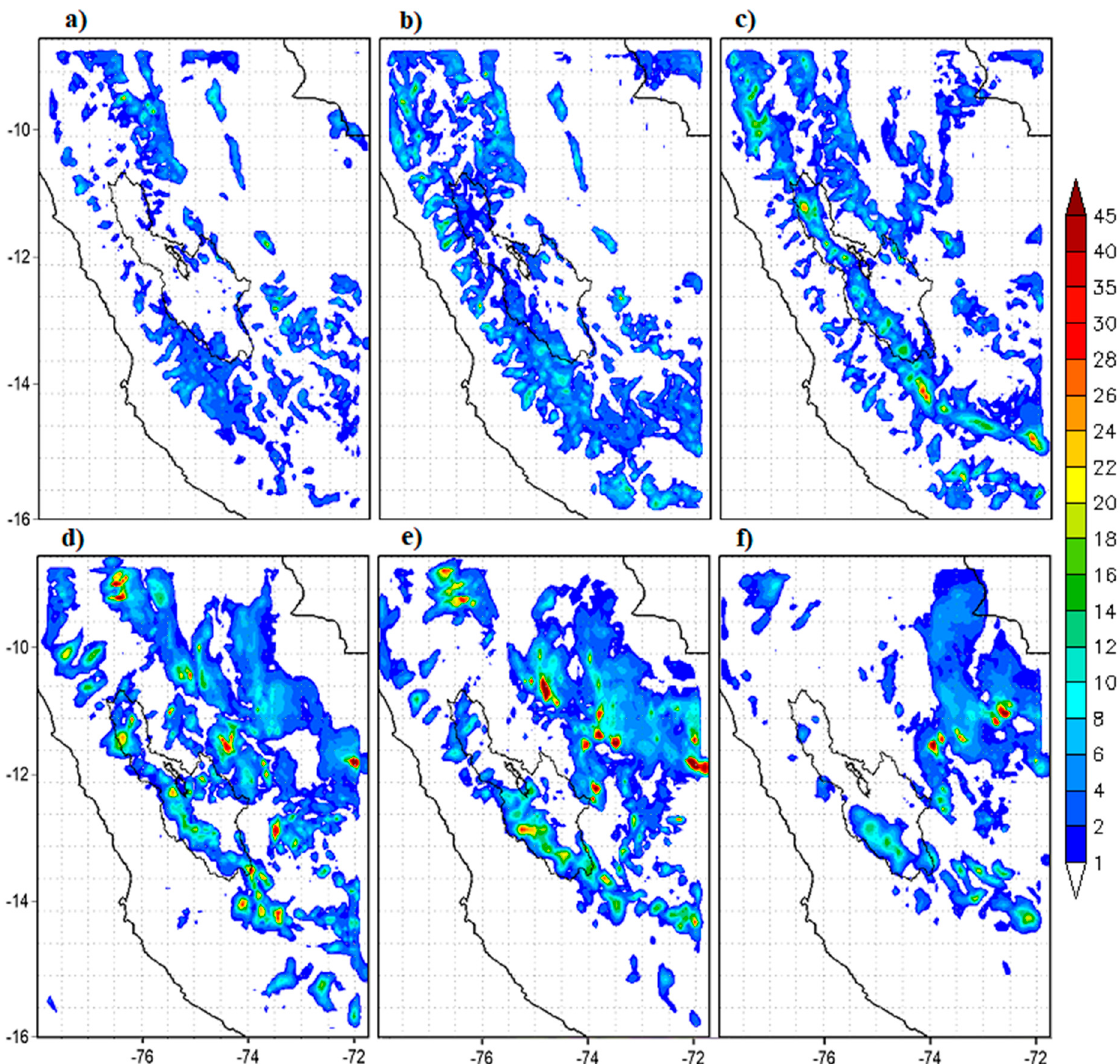
Figure 19. WRF-simulated precipitation (mm/3 h) at 13 LST, 16 LST, 19 LST, and 22 LST of 2 February ( a – d ); and 01 LST and 04 LST ( e , f ) of 3 February 2011.